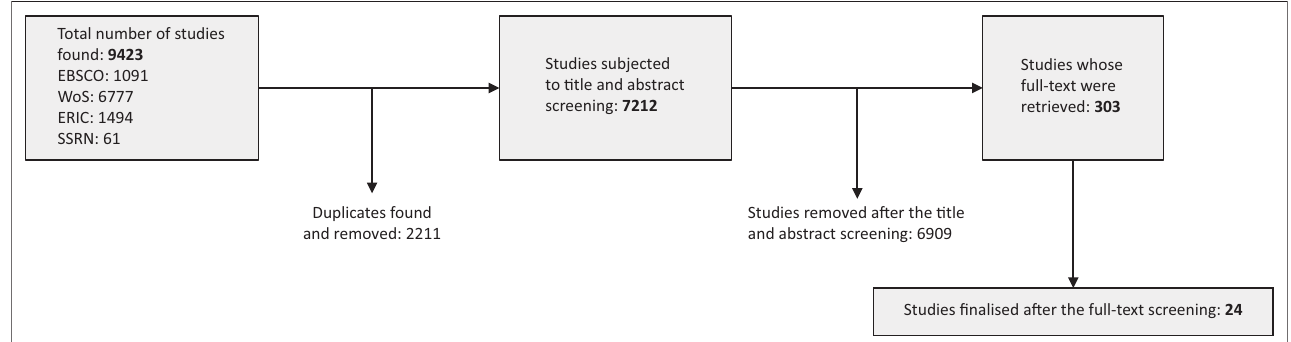
FIGURE 1: Identification of relevant studies. EBSCO, Elton B. Stephens Company; WoS, Web of Science; ERIC, Education Research Information Center; SSRN, Social Science Research